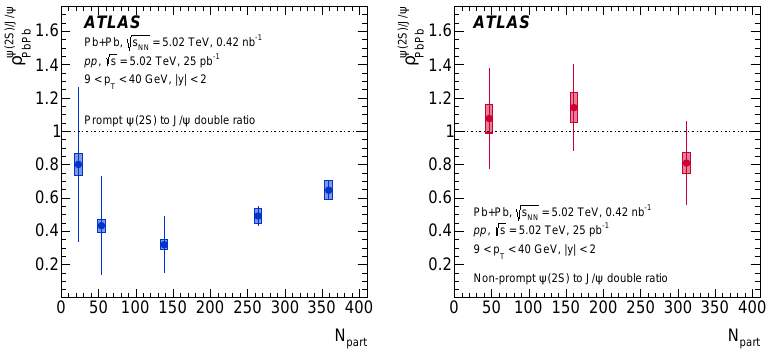
Figure 4. ψ (2S) to J /ψ double ratio, as a function of the number of nucleons participating in a collision, N part , for the (left) prompt and (right) non-prompt meson production. Figures are taken from Ref.